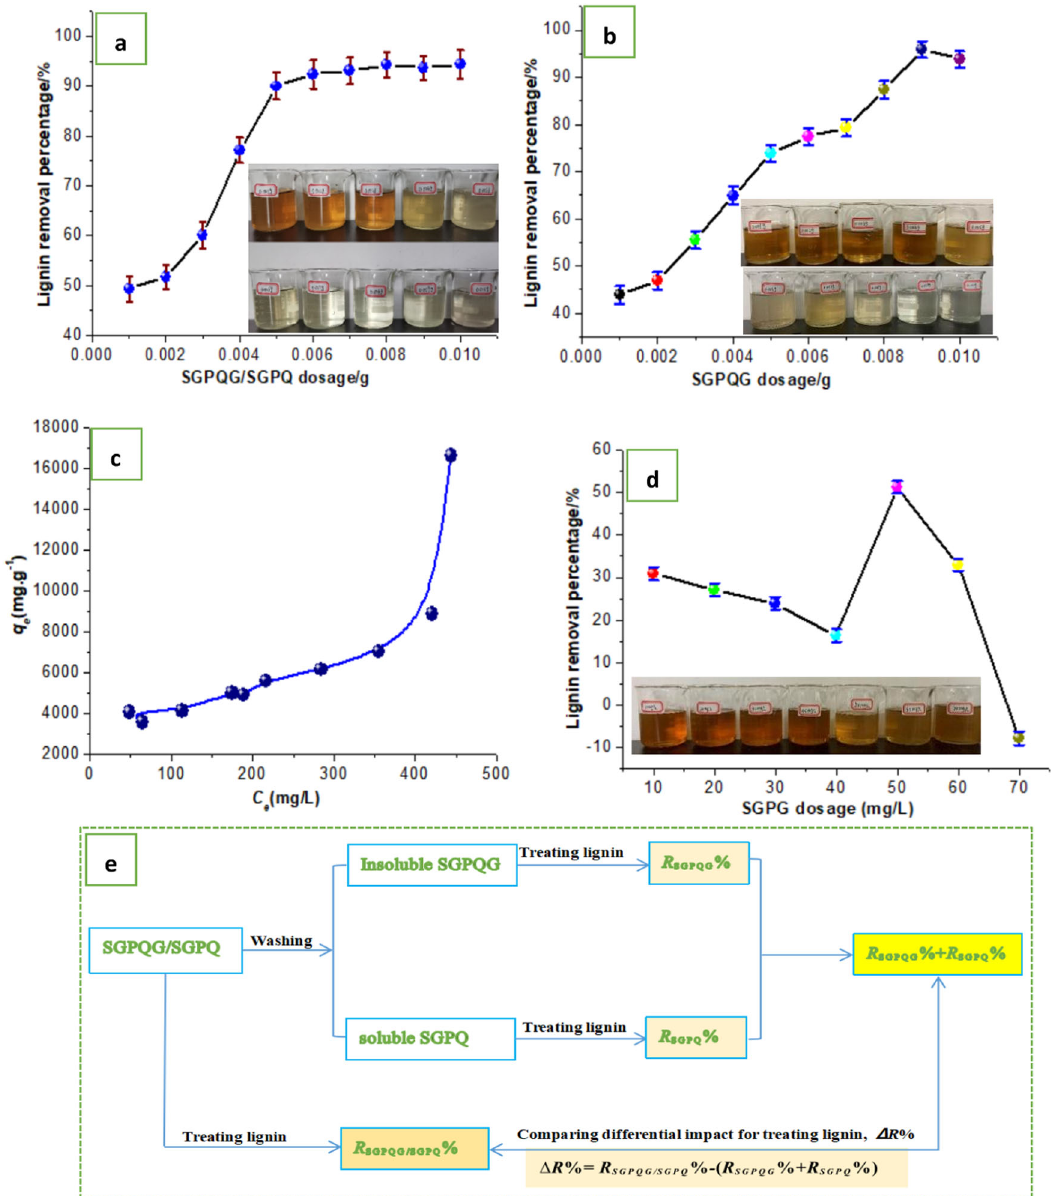
Fig. 2 SGPQG/SGPQ performances and differential impacts of each component. a The effect of different dosages of SGPQG/SGPQ materials on lignin removal. b The adsorption results of SGPQG skeleton towards lignin in water. c Isothermal adsorption curve of SGPQG skeleton towards lignin in water. d The fl occulation results of SGPQ fl occulant components towards lignin in water. e The differentiated impact analysis of the SGPQG/SGPQ composite material versus the separate SGPQG skeleton component and SGPQ fl occulant component. (*) R SGPQG/SGPQ %: the lignin removal percentage of SGPQG/SGPQ composite material, R SGPQG %: the removal percentage of the SGPQG skeleton component, R SGPQ %: the removal percentage of the SGPQ fl occulant component, Δ R %: the extra increase on the lignin removal